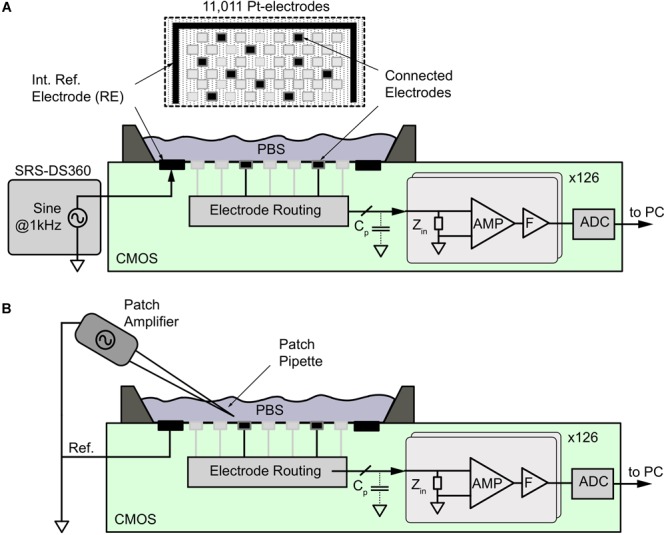
Noise and signal-attenuation measurements of electrodes by using the CMOS HD-MEA. (A) For signal attenuation measurements, a sinusoidal signal at 1 kHz from a DS360 signal generator was applied to the phosphate buffer solution (PBS) through an internal reference electrode (RE), while the signal was acquired from different electrode types within the 11,011-electrode array as shown at the top. For noise measurements, the reference electrode was disconnected from the signal source, and a fixed potential was applied. The electrode-electrode interface noise was then amplified (AMP), filtered (F), and digitized (ADC) by using the internal voltage recording channels. (B) A Patch amplifier and pipette was used to generate point-source signals to evaluate the averaging effect of the electrodes of different sizes.